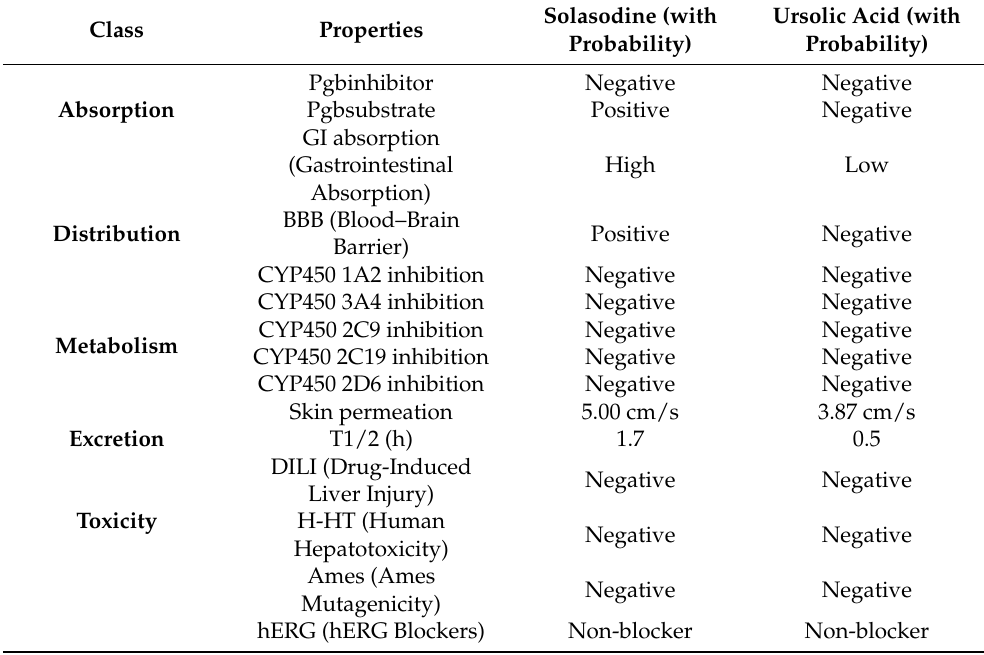
Table 4. ADME and toxicity studies of selected ligand